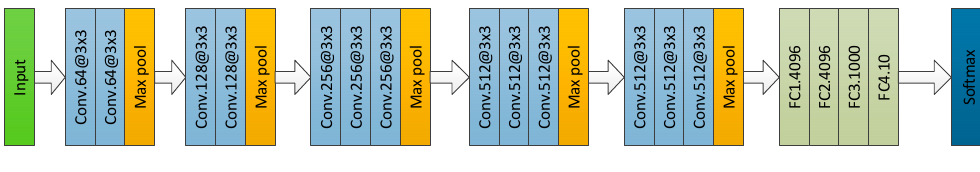
Figure 4. The architecture of VGGNet. SAR images need to be pre-processed before training and testing. According to the experience, we take the original image minus its mean as